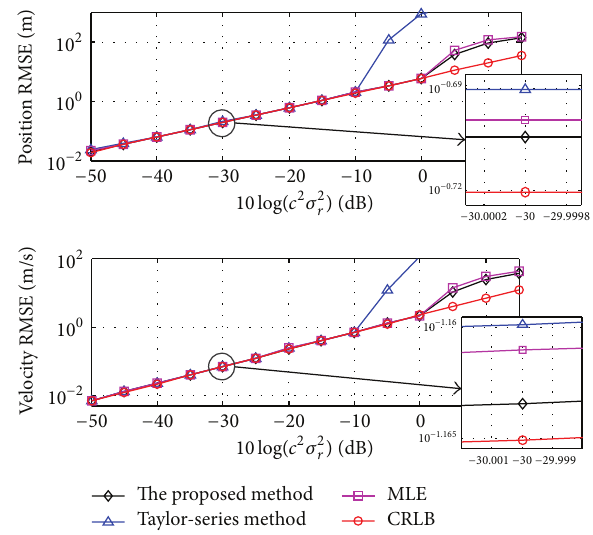
Figure 4: Comparison of root mean square error (RMSE) of the proposed method with the original MLE, Taylor-series method, and the CRLB for near-field source. The accuracy is shown in log scale as the noise power